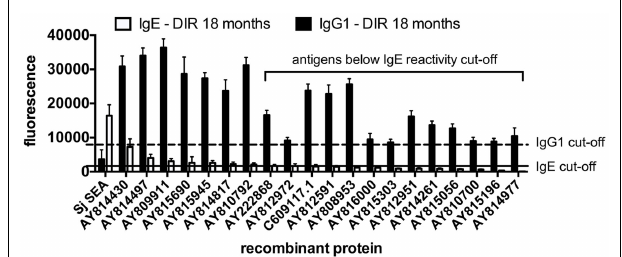
FIGURE 4 | Some arrayed antigens that induce IgG1 responses in Schistosoma haematobium -infected humans who acquire drug-induced resistance after praziquantel treatment are not the targets of IgE . Average adjusted signal intensity values depicting IgG1 and IgE antibody responses to each IgG1 antigen reactive to post-treatment sera from drug-induced resistant (DIR) humans. The dashed and solid lines are the respective cut-offs for IgG1 (8239) and IgE (1861) reactivity, calculated as one standard deviation of the mean of the no-DNA control spots on the array. Schistosoma japonicum SEA is included for comparative